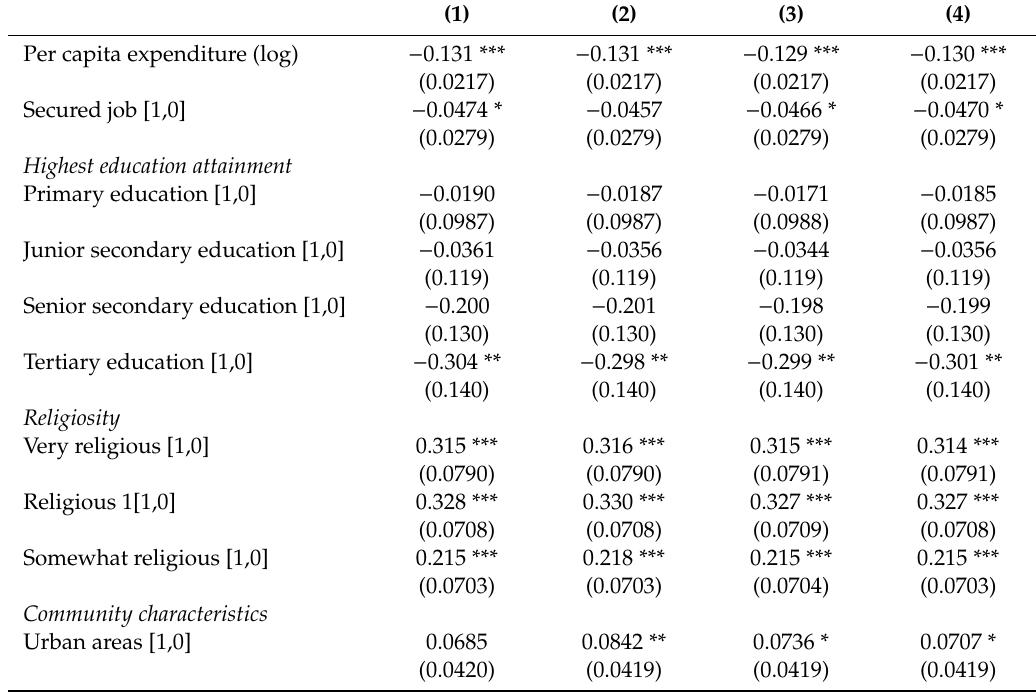
Table 3. Regression results (Dependent variable: Index of overall religious